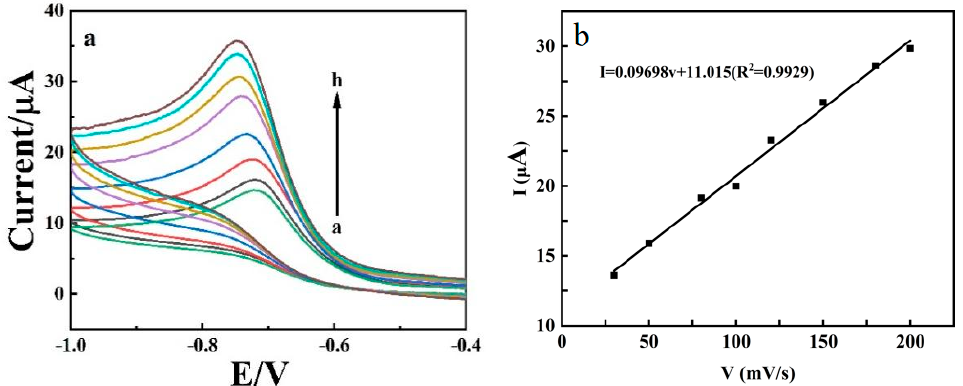
Figure 7. ( a ) CV curves of CLR-PC/GCE toward 100 µ mol · L − 1 4-NP at different scan rates: 30, 50, 80, 100, 120, 150, 180 and 200 mV · s − 1 (from a to h); ( b ) The calibration plot of peak current versus scan rate.